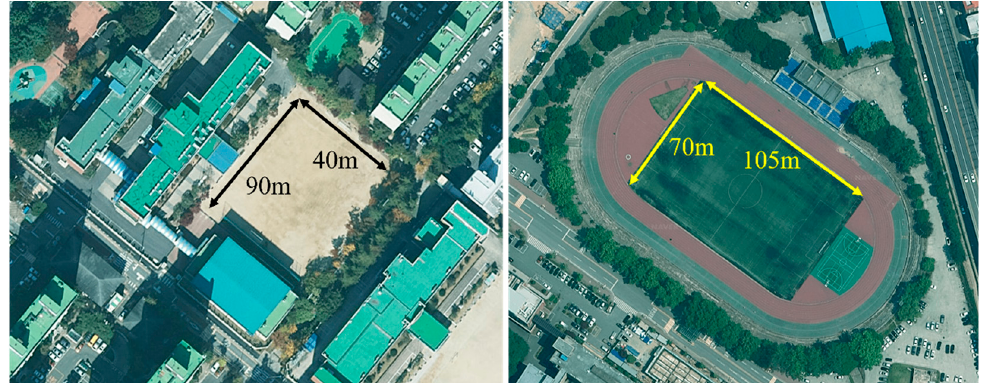
Figure 5. The two outdoor data collection environments used in this study. Table 2. Deep learning model hyperparameters used in the experiments in this study. Batch